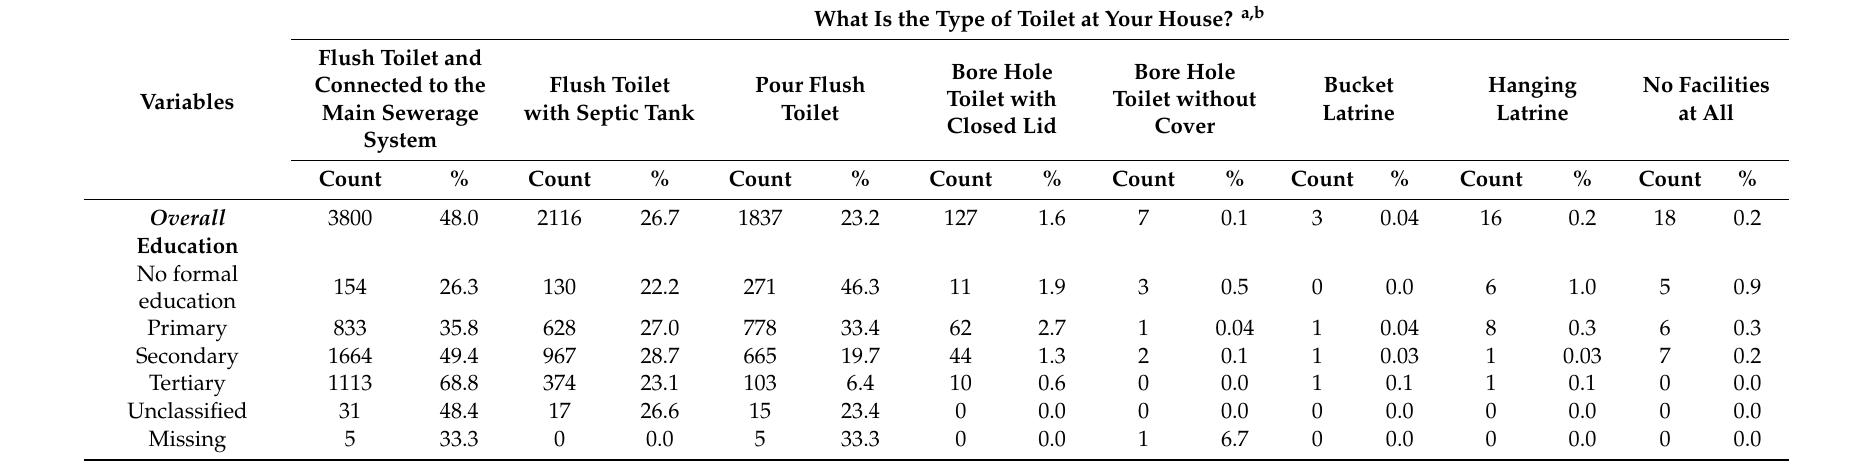
Table A2. Relationships between socio-economic factors and type of toilet used by